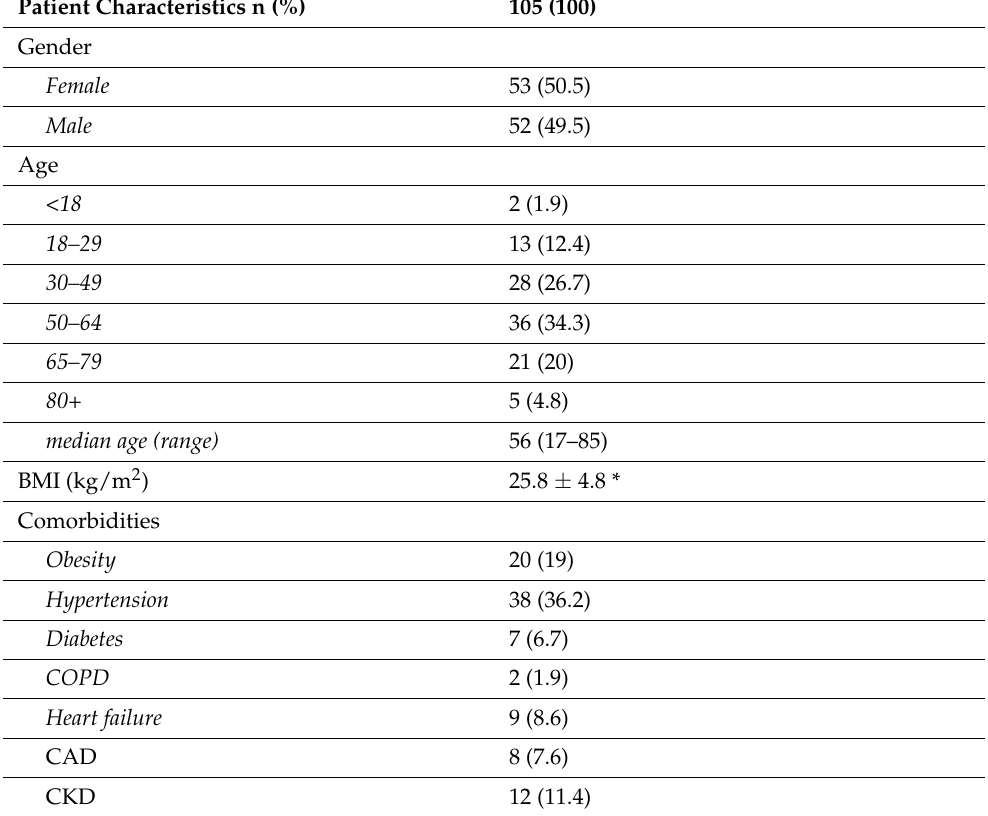
Table 1. Patient characteristics. Data are shown as patients per category and percentage of the total population. Abbreviations: COPD—chronic obstructive pulmonary disease, CAD—coronary artery disease, IMV—invasive mechanical ventilation, NIV—non-invasive ventilation, ECMO— extracorporeal membrane oxygenation. SOFA—Sequential Organ Failure Assessment. BMI—body mass index. ICU—intensive care unit. SD—standard deviation. TPE—therapeutic plasma